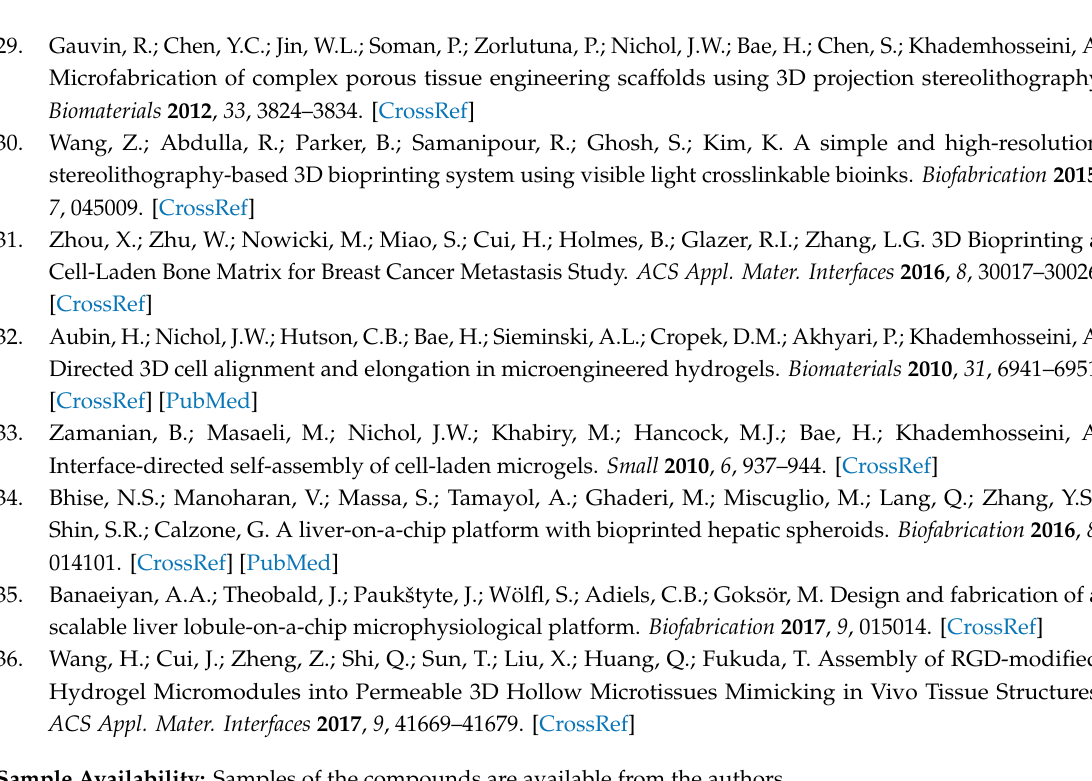
Sample Availability: Samples of the compounds are available from the